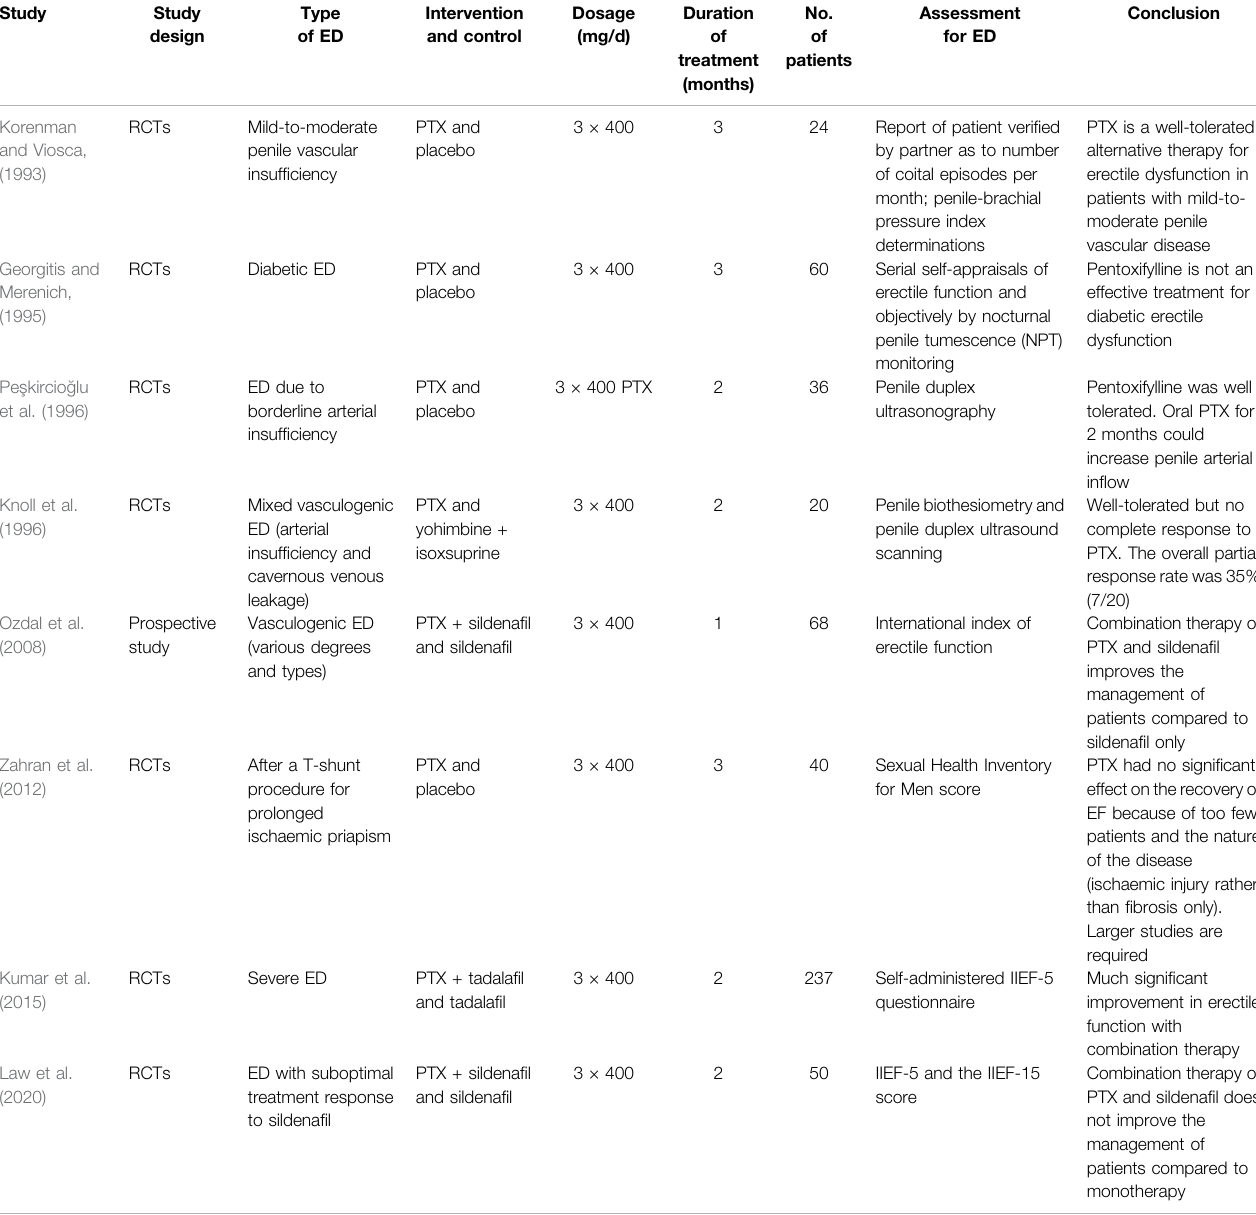
TABLE 4 | The effect of oral PTX in